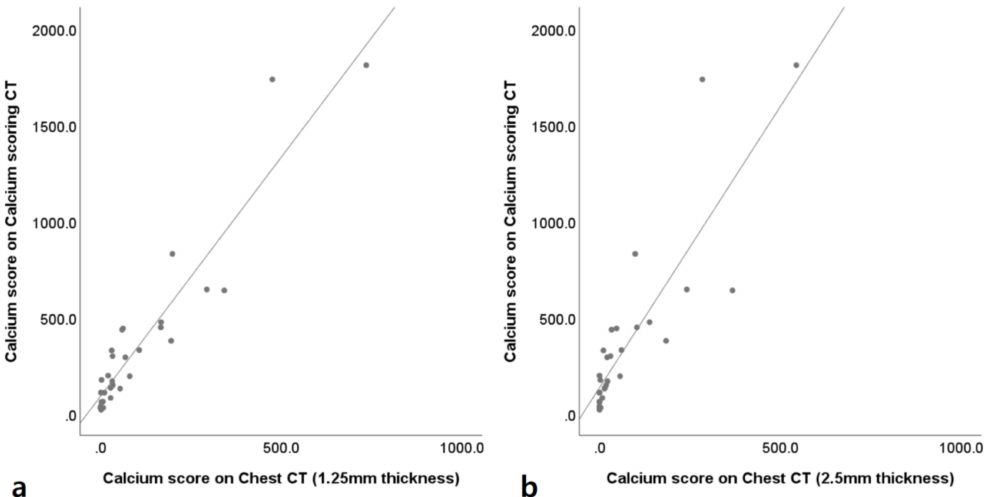
Figure 4. Correlation between calcium-scoring CT and chest dual energy CT. Scatter plots between calcium-scoring CT and virtual unenhanced (VUE) images of enhanced chest dual energy CT (DECT) with 1.25 mm slice thickness ( a ) and 2.5 mm slice thickness ( b ). The correlation coefficients of coronary artery calcium scoring between the coronary calcium-scoring CT and VUE images of chest DECT with 1.25 mm and 2.5 mm slice thicknesses are 0.904 and 0.888.